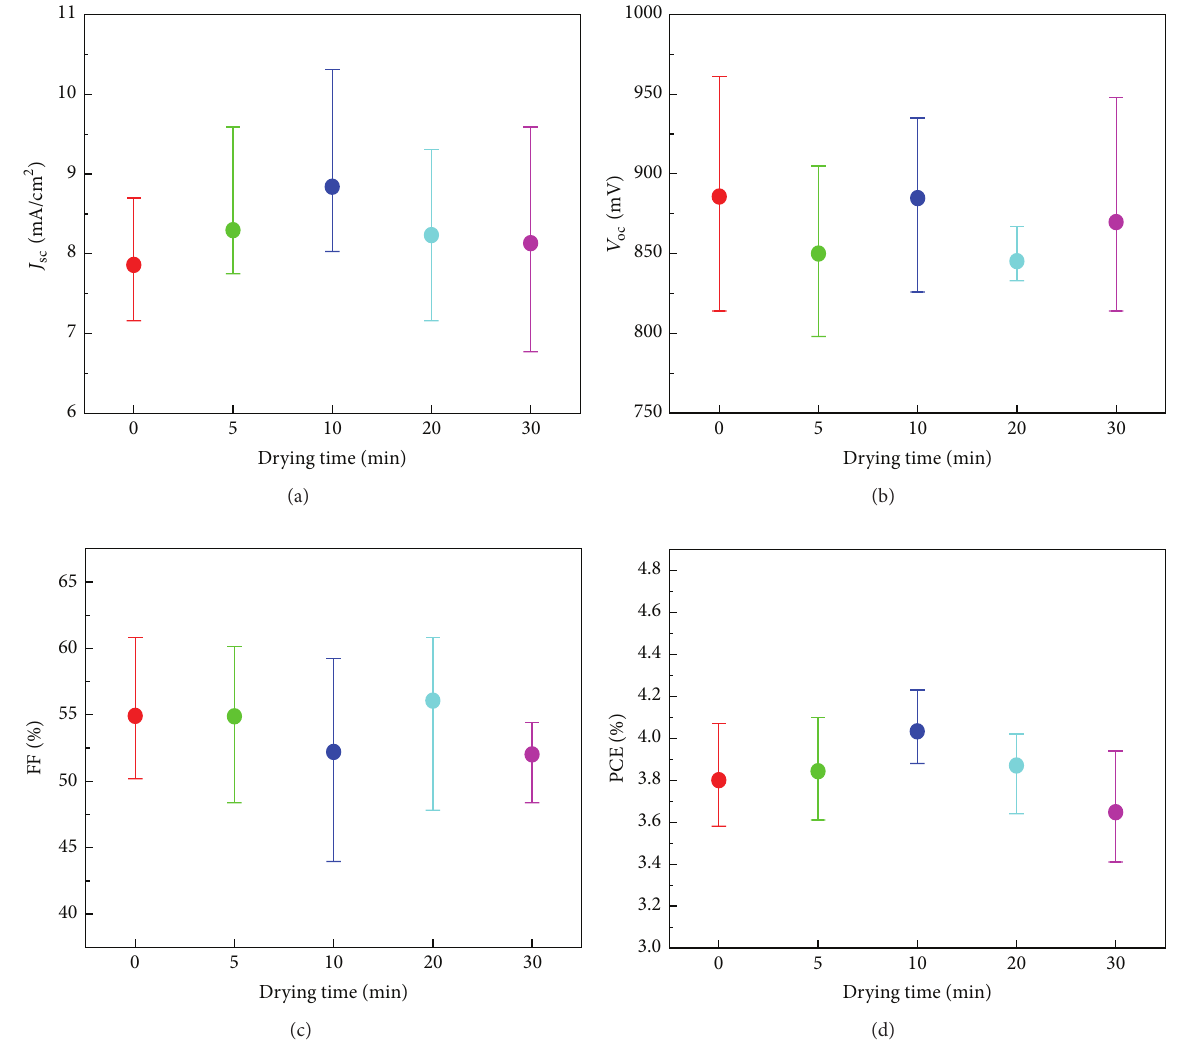
Figure 6: 𝐽 - 𝑉 characteristics of MPSCs based on MAPbI 3 perovskite thin films depending on the different drying time, after spin-coating PbI 2 solution: (a) 𝐽 sc , (b) 𝑉 oc , (c) FF, and (d) PCE.